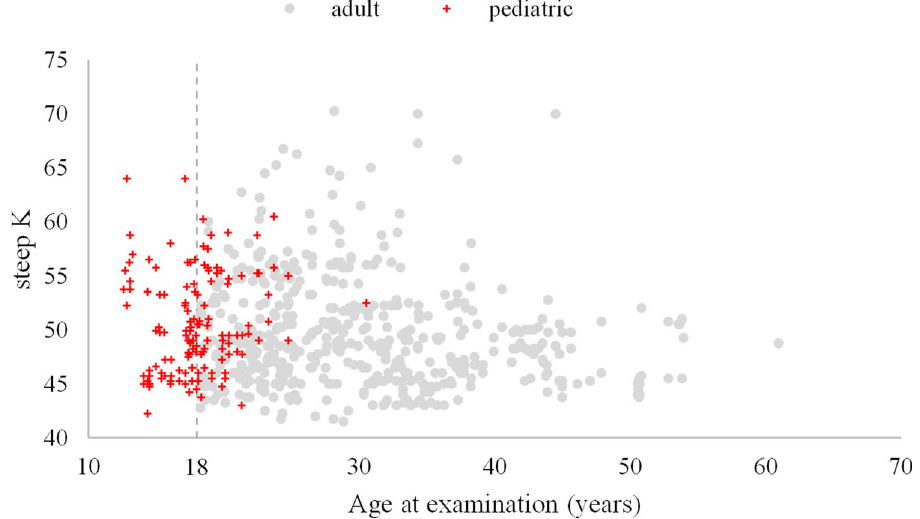
Figure 2. Steep K and age among patients with keratoconus from the initial diagnosis to the final visit before treatment (867 observations, r =